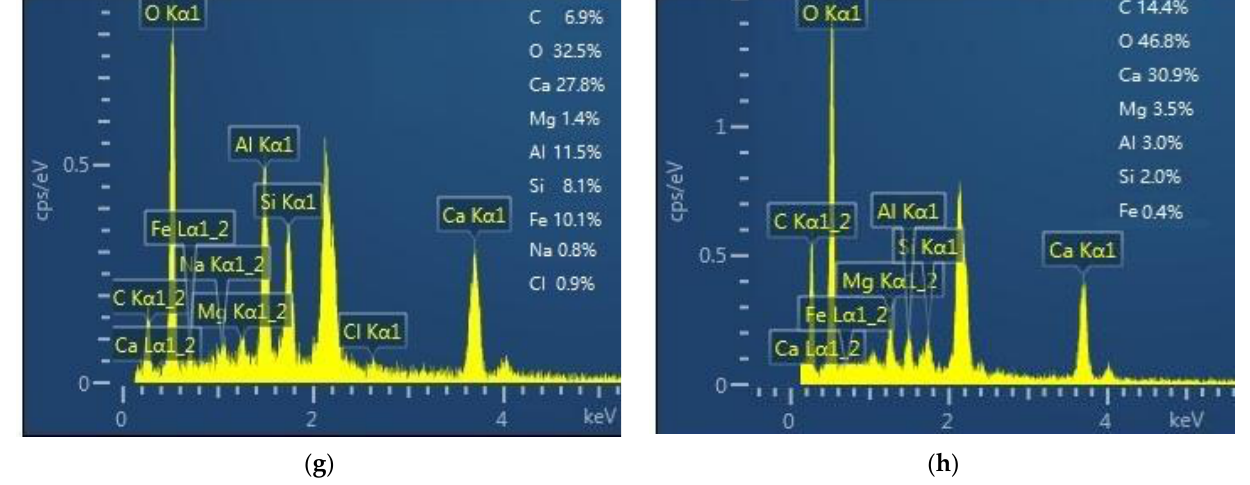
Figure 9. The morphology and EDS spectra of samples. ( a ) The morphology of SSD. ( b ) The mor- phology of SSW. ( c ) The morphology of D-C24. ( d ) The morphology of W-C24. ( e ) The morphology of D-W28. ( f ) The morphology of W-W28. ( g ) The EDS spectra of Mc in ( e ). ( h ) The EDS spectra of vaterite in ( f ). Mc denotes monocarboaluminate. % in EDS spectra are weight %.